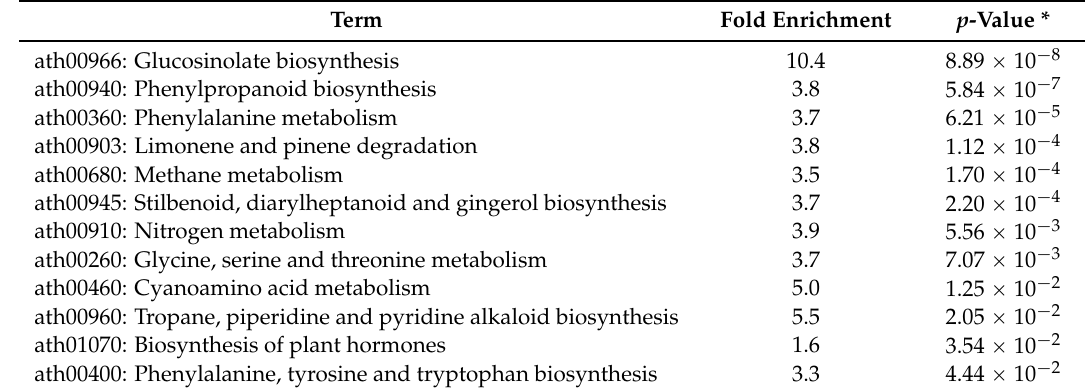
Table 1. Overrepresented KEGG pathways among upregulated A. thaliana root transcripts 14 dpi [15]. Term Fold Enrichment p -Value * ath00966: Glucosinolate biosynthesis 10.4 8.89 ˆ 10 ´